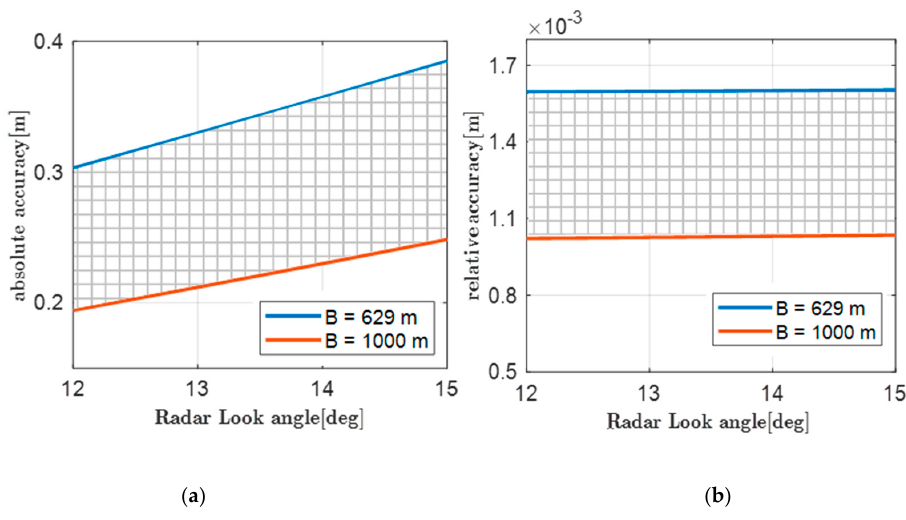
Figure 18. The altimetric error determined by an equivalent baseline inclination error. ( a ) The absolute